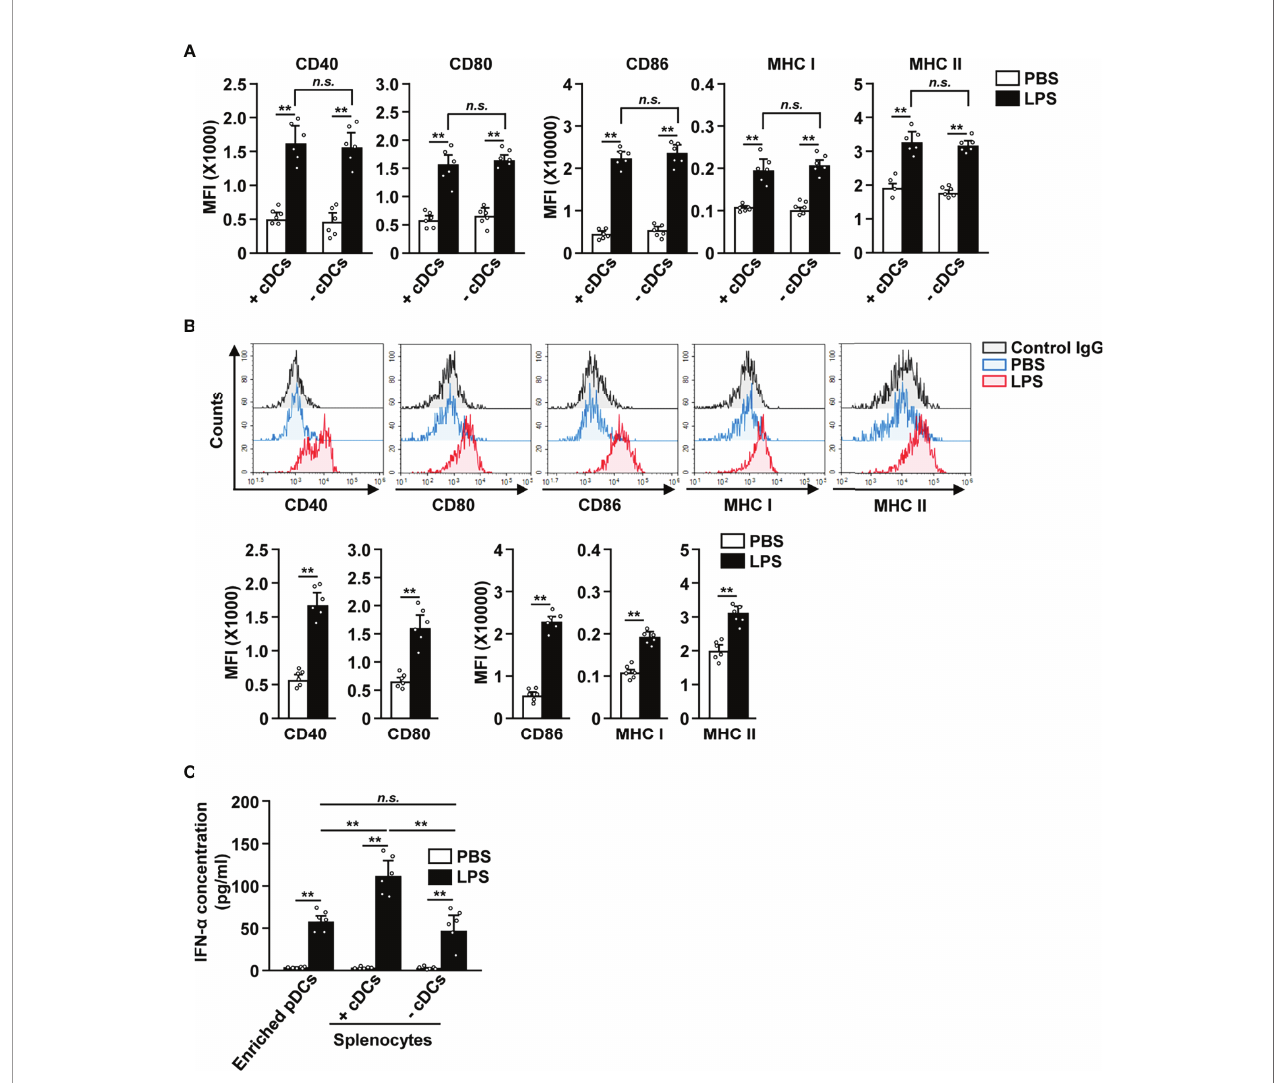
FIGURE 4 | LPS upregulated the surface activation markers of pDCs without interacting with cDCs. (A) Total splenocytes (+cDCs) and cDC-depleted splenocytes ( − cDCs) were incubated with 0.1 m g/ml LPS. Expression of the markers indicated above (CD40, CD80, CD86, and MHC I and II) was measured in pDCs by fl ow cytometry, 12 h after LPS treatment (n = 6 mice, two-way ANOVA, mean±SEM, **p < 0.01 ). (B) The expression levels of co-stimulatory molecules and class I and II MHC were measured in isolated pDCs 12 h after treatment with 0.1 m g/ml LPS (Upper panels). MFI of co-stimulatory molecules and class I and II MHC was shown (lower panels, n = 6 mice, two-way ANOVA, mean±SEM, **p < 0.01 ). (C) IFN- a concentration in cultured medium was measured by ELISA (n = 6 mice, two-way ANOVA, mean±SEM, **p < 0.01 , n.s., none signi fi